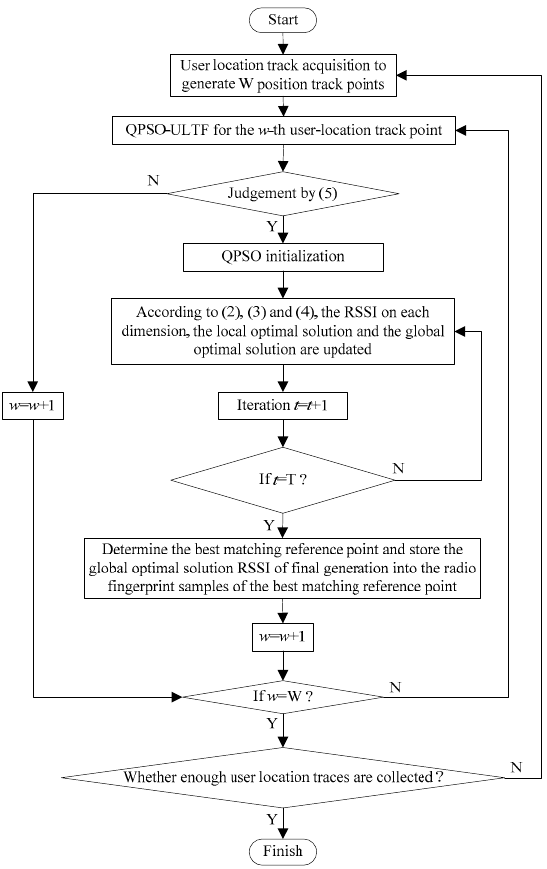
Figure 4. The flowchart of the adaptive construction method of radio fingerprint database based on